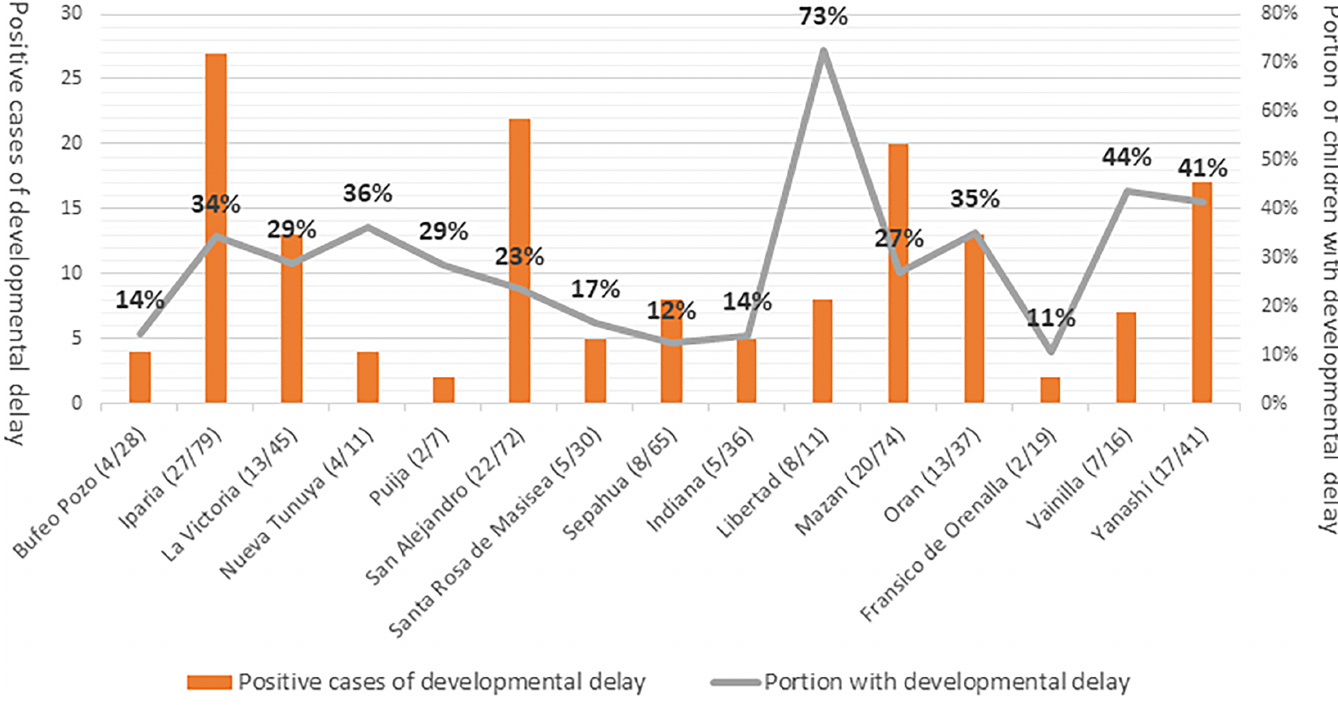
Fig 1. Prevalence of developmental delay in each participating community among Amazonian communities of Peru.